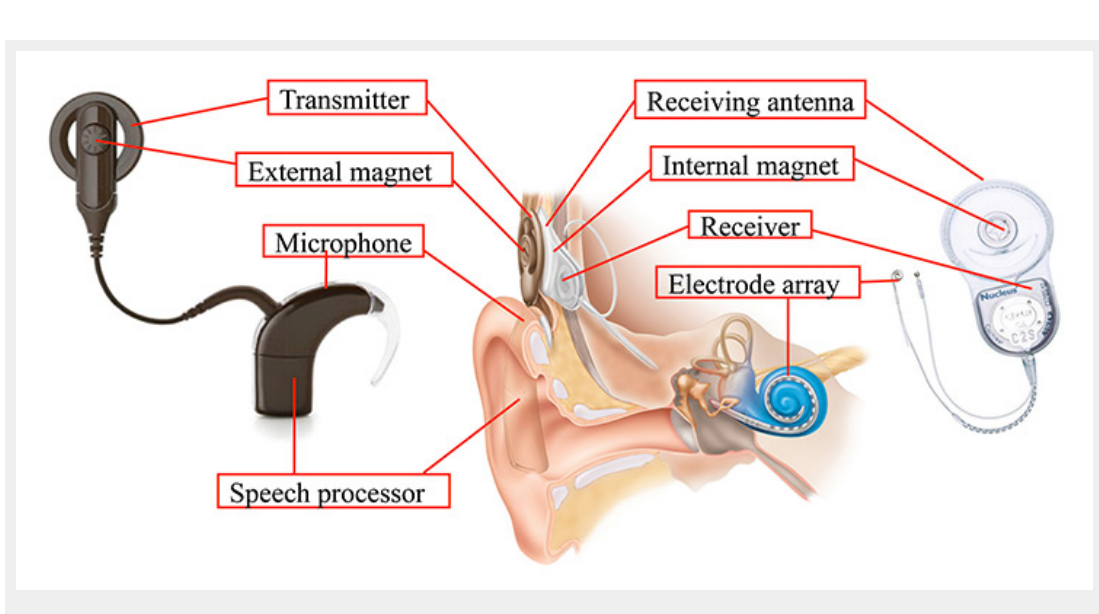
Illustration of cochlear implant components. The external parts are shown on the left, the internal components of the implant on the right. The scheme in the middle shows the position of the cochlear implant components in situ